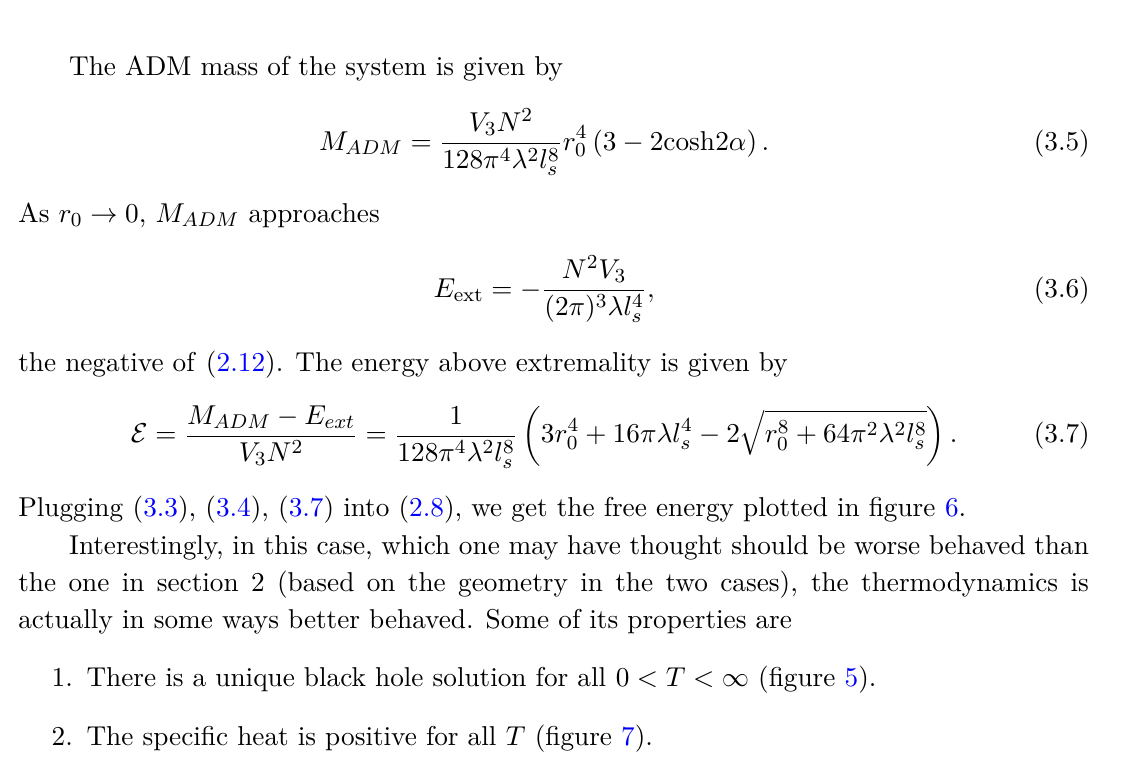
Figure 6 . Free energy for negative